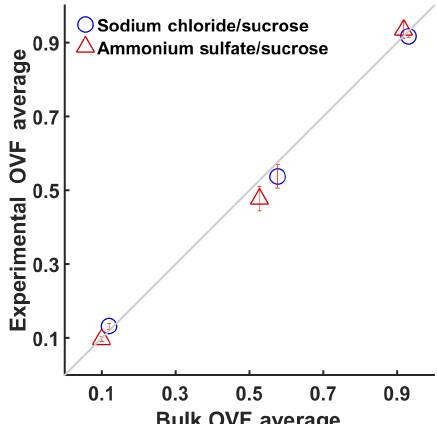
Figure 5. Correlation between experimentally determined aver- age OVFs and calculated average OVFs for the sodium chlo- ride / sucrose (blue circles) and ammonium sulfate / sucrose (red triangles) systems. A 1 : 1 line is shown in gray. Error bars repre- sent standard error calculated by SE = ( 1 . 96 · S)/(N 1 / 2 ) , where S is the standard deviation, N is the number of particles, and 1.96 is the approximate number of standard deviations encompassing the central 95% of a student’s t distribution (Skoog et al., 2007). Error in bulk OVF is too small to be